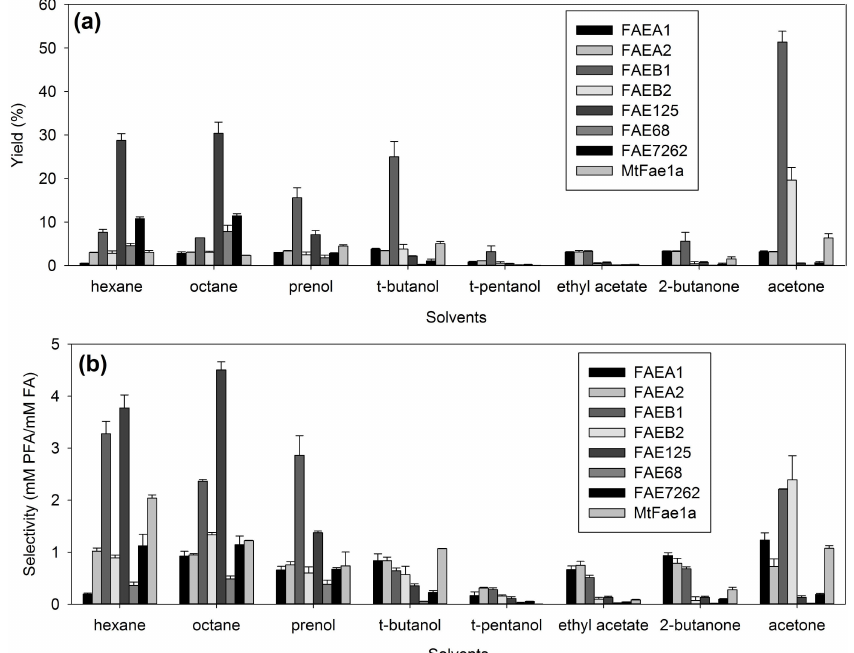
Figure 1. Effect of organic solvents on the synthesis of prenyl ferulate from the obtained CLEAs. ( a ) Product yield (%), ( b ) selectivity.